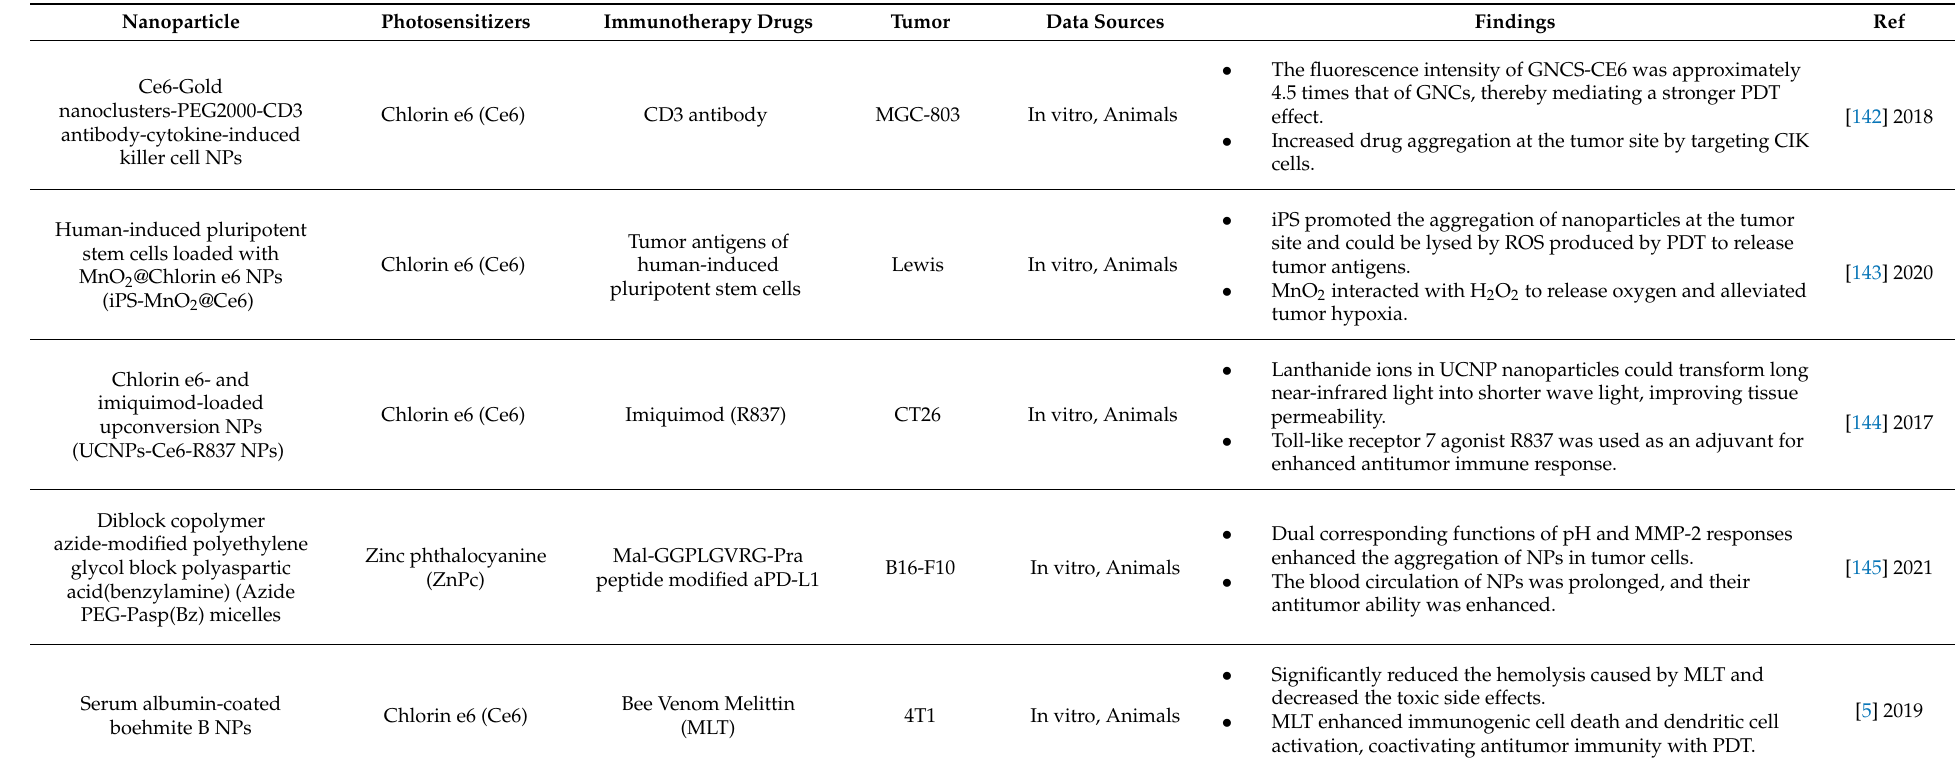
Table 3. Codelivery of photosensitizers and immunotherapy drugs based on